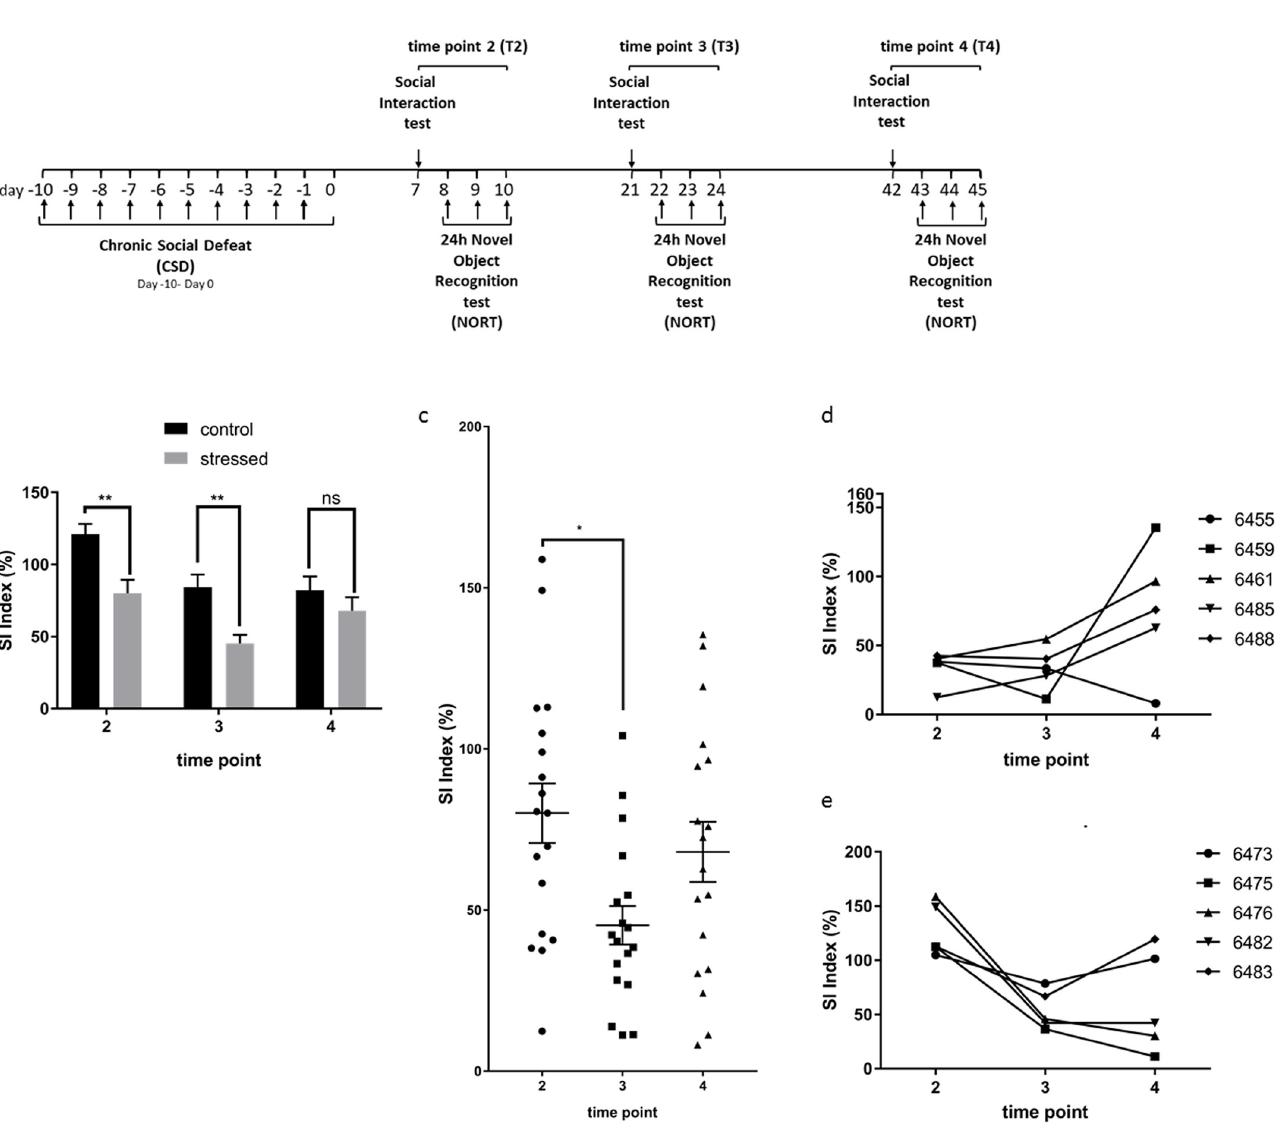
Fig 2. Longitudinal development of social interaction behavior after CSD stress. (a) Experimental setup timeline for retesting. Animals of a cohort of mice were (re-)tested for SI and NORT at 7–10 days (T2), 21–24 days (T3) and 42–45 days (T4) post CSD. (b) Re-testing of social interaction behavior at T2-T4 of non- stressed and stressed animals (T2 p = 0.0026, T3 p = 0.0045, T4 p = 0.7145, 2-way repeated measures ANOVA and Bonferroni’s post hoc test). SI indices of control animals significantly decreased at time points T3 and T4 compared to T2 (T2 vs T3 p = 0.008, T2 vs. T4 p = 0.005, T3 vs. T4 p > 0.999, 2-way repeated measures ANOVA followed by Bonferroni’s post-hoc test) (c) Group dynamics of social interaction behavior in stressed mice at three different time points (T2-T4). SI scores were significantly lower at T3 compared to T2 and recovered at T4 (T2 vs. T3 p = 0.017, T2 vs. T4 p = 0.977, T3 vs. T4 p = 0.197, 2-way repeated measures ANOVA followed by Bonferroni’s post-hoc test). (d) Longitudinal trajectories of stressed animals at T2-T4 of the 5 worst performers chosen at T2. (e) Longitudinal trajectories of stressed animals at T2-T4 of the 5 best performers chosen at T2. Data are shown as mean ± standard error of the mean and individual